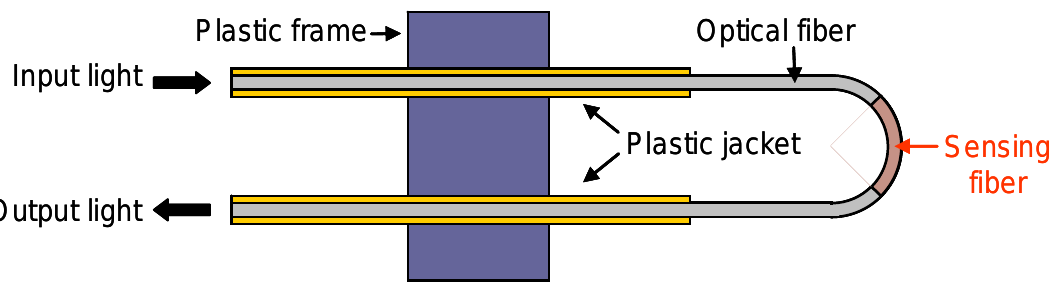
Figure 8. U - Shaped evanescent wave sensor probe.